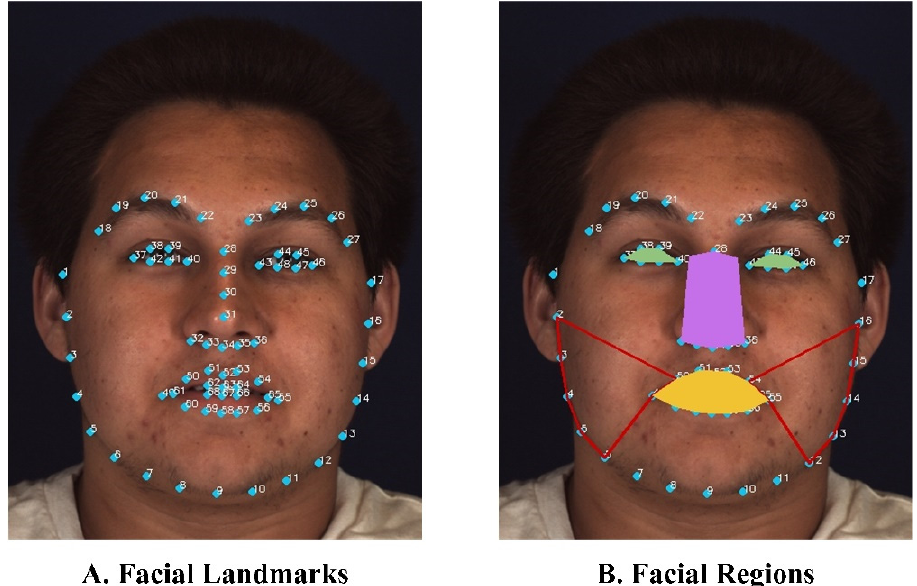
Figure A2. Diagram of facial regions division. ( A ) The 68 coordinates to determine the facial structure. ( B ) The different colored lines represent different facial regions. Green is the eye area, red is the cheek, yellow is the mouth, and purple is the nose. Note. The picture is for demonstration purposes only. The data are from the BP4D dataset [35,36].